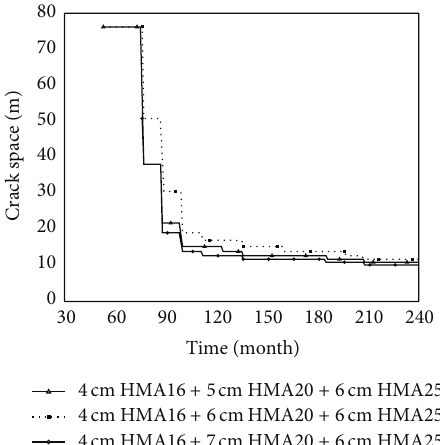
Figure 5: Influence of base type on thermal cracking space on asphalt